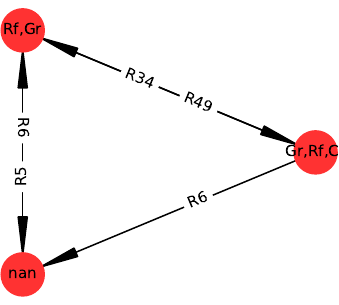
Figure A4. STG of the attractor of the “dry period” scenario. Graph nodes and edges represent ecosystem states and transitions, respectively. Node labels correspond to active variables, with Rf : Rainfall, Gr : Grass, and Cr : Crops. Edge labels correspond to rules driving transitions (see Table A2). Node color is